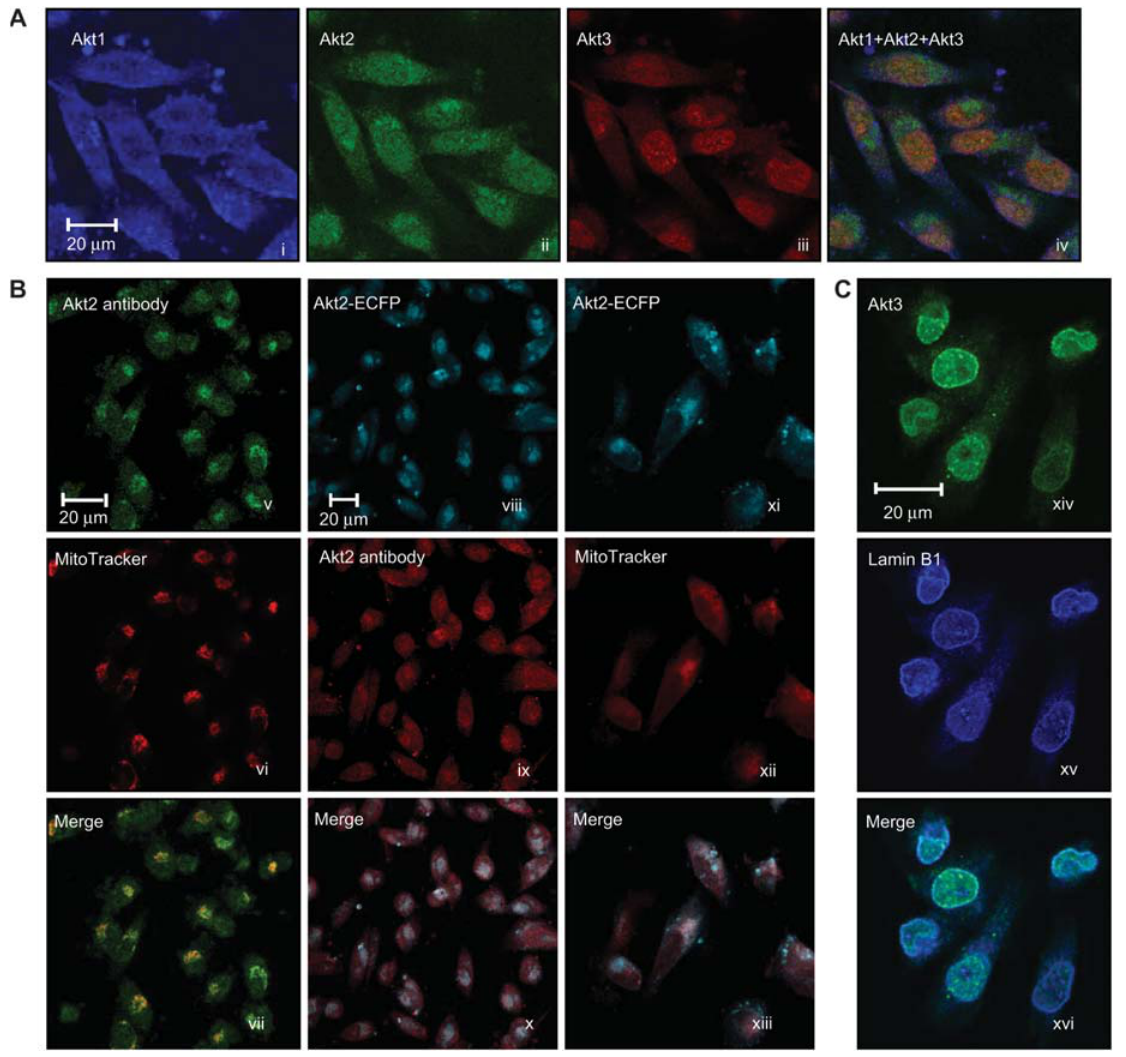
Figure 2 The Akt isoforms are localized in different subcellular compartments. (A) Triple staining of MDA-MB231 cells showed distinct subcellular localization patterns. Cells were immunostained with antibodies against Akt1 (blue, panel i), Akt2 (green, panel ii) and Akt3 (red, panel iii). Note that Akt1–3 are localized in the cytoplasm, mitochondria, and nucleus, respectively. (B) Akt2 was confirmed to colocalize with the mitochondria. Colocalization of Akt2 with MitoTracker Red is shown in panels v–vii. Ectopically expressed recombinant Akt2 proteins (Akt2-ECFP, panels viii–x; Akt2-ECFP, panels xi–xiii) were also localized at mitochondria. (C) Akt3 is localized in the nucleus. Lamin B1 was used as a nuclear marker. The data were originally published in (9) and are reprinted here with